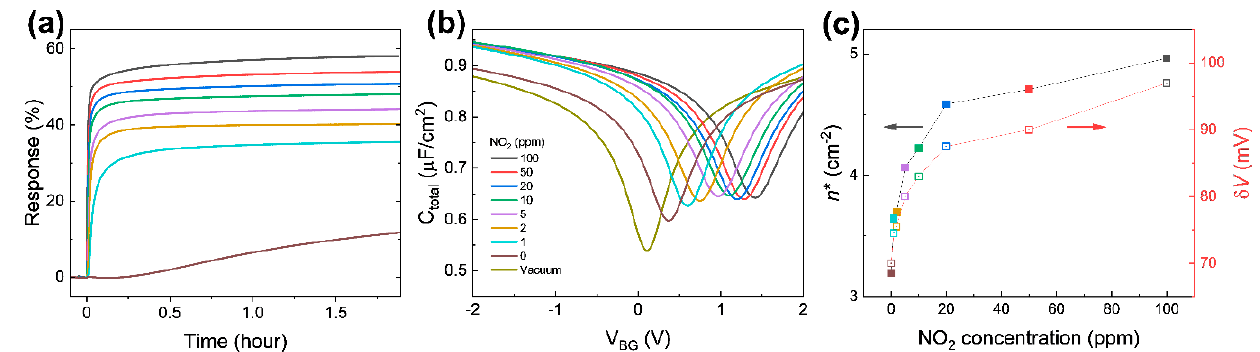
Figure 6. ( a ) Capacitive response at different NO 2 concentrations for approximately 2 h. ( b ) C total as a function of V BG 2 h after exposure to different NO 2 concentrations. ( c ) Extracted residual carrier density and potential variance from ( b ).